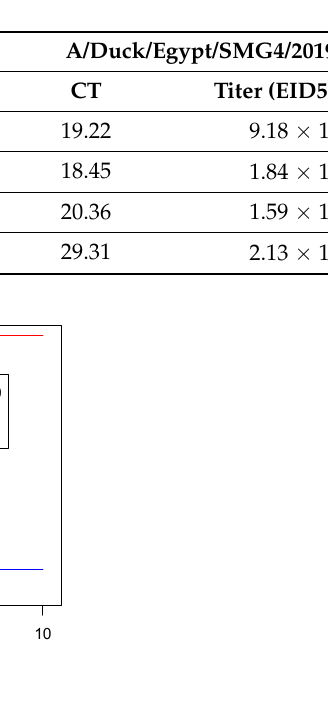
Figure 4. Survival rate showing the daily mortality in each chicken group after infection.